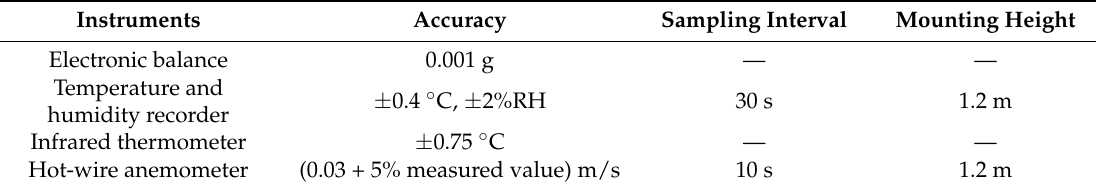
Table 1. Accuracies, sampling intervals, and mounting heights of instruments.